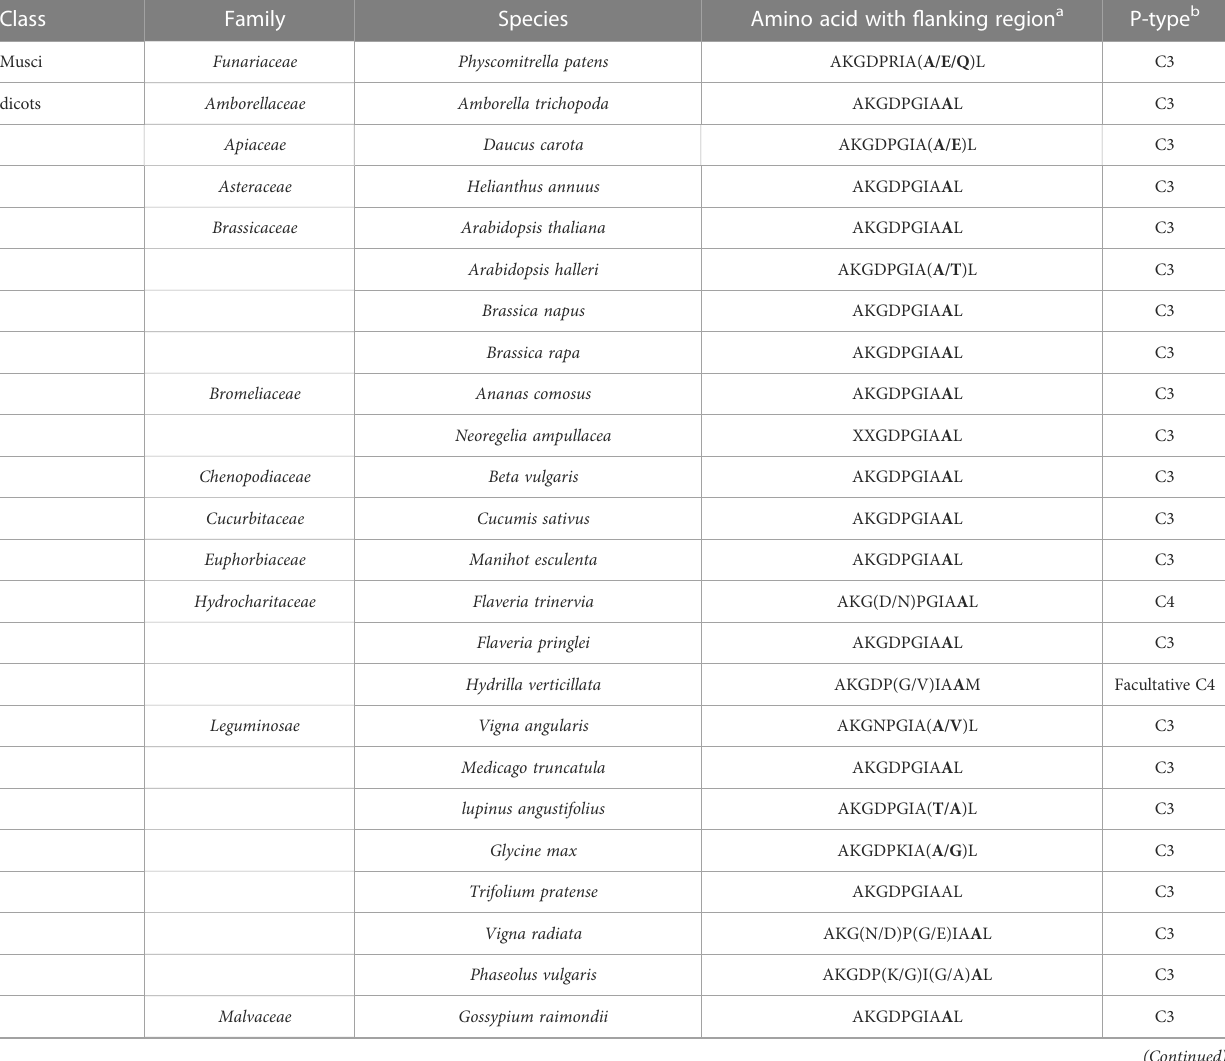
TABLE 5 Amino acid (9 th position, bold) for C 4 -speci fi c PEPC.